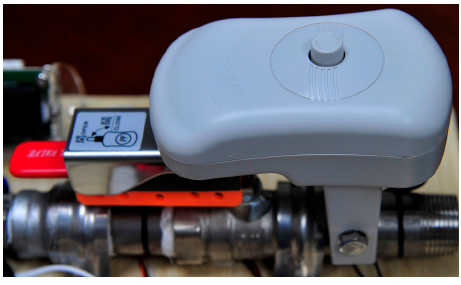
Figure 10. Gas shutoff device.